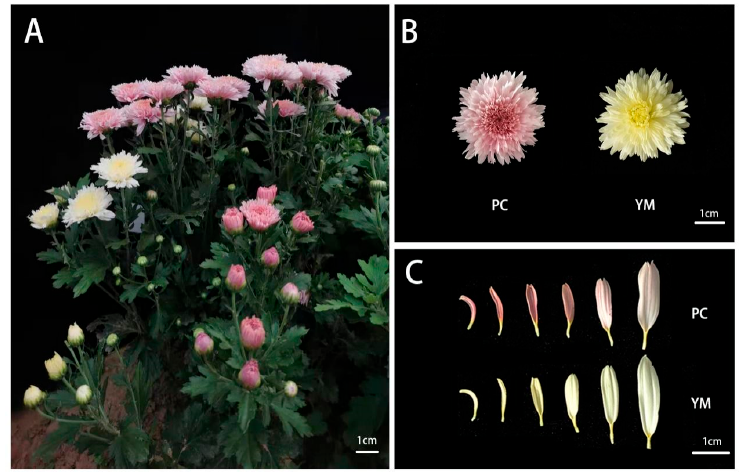
Figure 1. Phenotypic differences between ‘Pink Candy’ (PC) and yellow-colored mutant (YM) chrysanthemum flowers. ( A ) The phenotypes of PC and YM under standard cultivation conditions. ( B ) Top view of inflorescences of PC and YM at the full-bloom stage. ( C ) The phenotypes of different layers of ray florets of PC and YM. Bar = 1 cm.